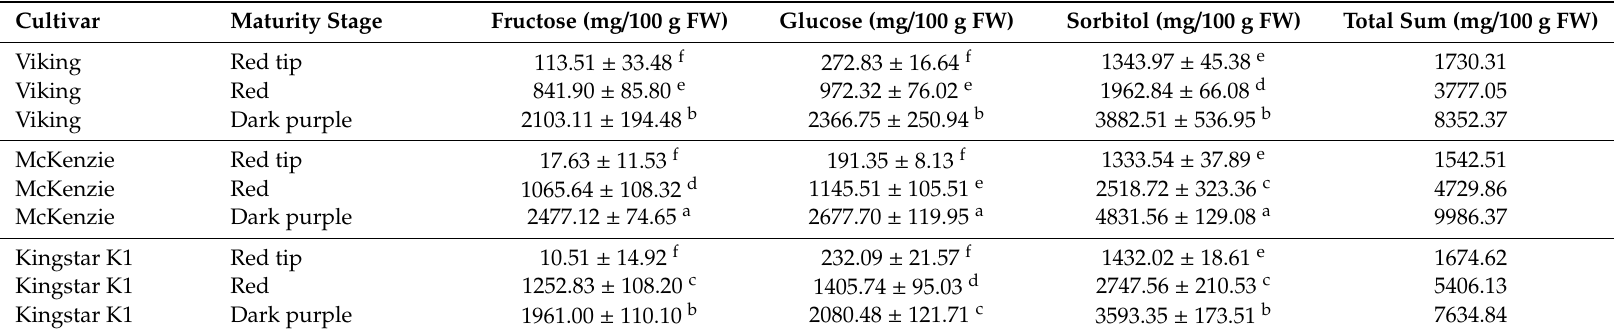
Table 3. Individual sugar contents of Aronia melanocarpa fruits at di ff erent maturity